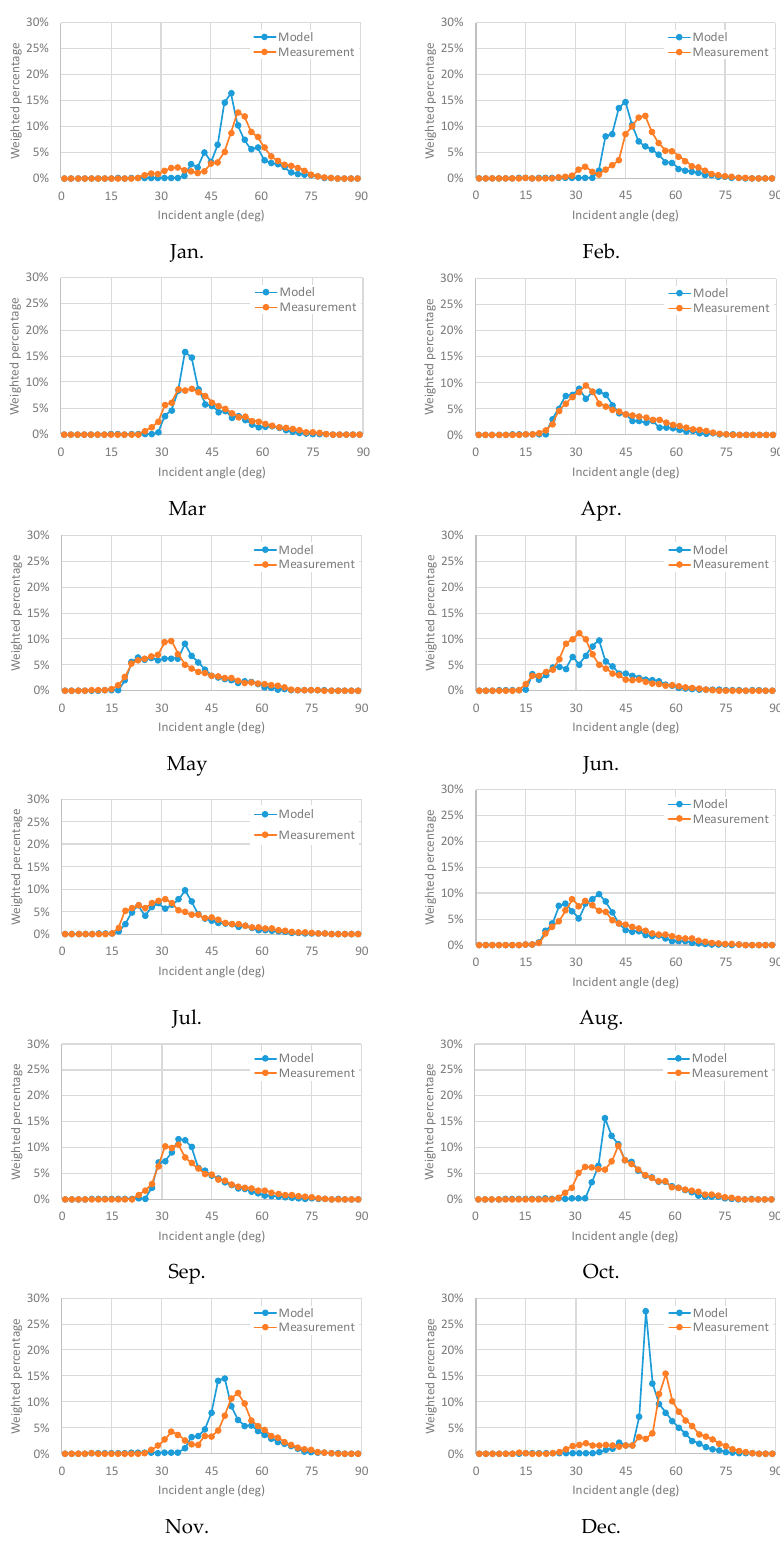
Figure 18. Monthly integrated angular distribution (weighted histogram of the leading solar beam).